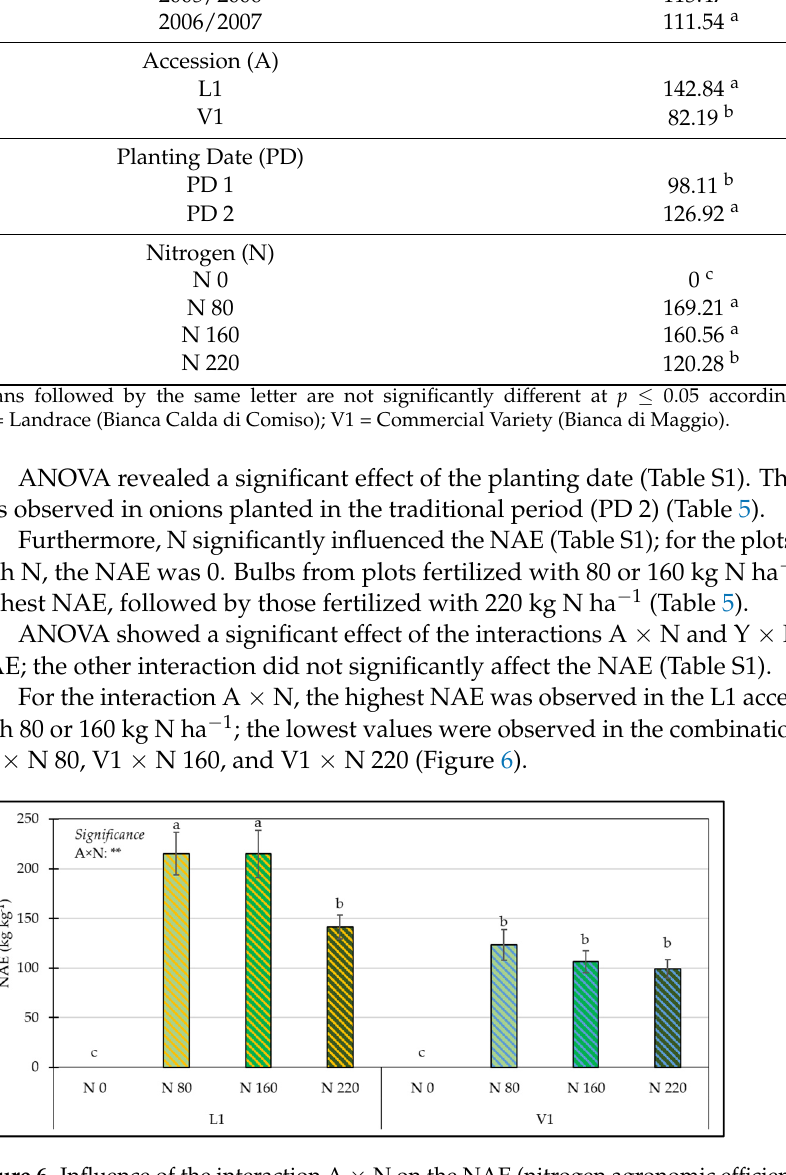
Figure 7. Influence of the interaction Y × N × PD on the NAE (nitrogen agronomic efficiency). Means followed by the same letter are not significantly different at p ≤ 0.05 according to Tukey’s test. Bars represent the standard error. ** = significant at p ≤ 0.01; Y = Year; N = nitrogen; PD = Planting Date; N 0 = No-Nitrogen Fertilization; N 80 = fertilization with 80 kg N ha − 1 ; N 160 = fertilization with 160 kg N ha − 1 ; N 220 = fertilization with 220 kg N ha − 1 ; PD 1 = Early Planting Date; PD 2 = Traditional Planting Date. 3.4. Cost–Benefit Analysis Cost–benefit analysis, expressed as an average of the two agricultural years, showed that the highest net benefit of EUR 21,746 was obtained by applying a N dose of 220 kg ha − 1 for the L1 accession. The lowest net benefit of EUR 6139 was obtained for the V1 ac- cession with a nitrogen application of 80 kg ha − 1 (Table 6). Table 6. Cost–benefit analysis of the two onion accessions expressed as an average of the two agri- cultural years. Accession Planti ng Date